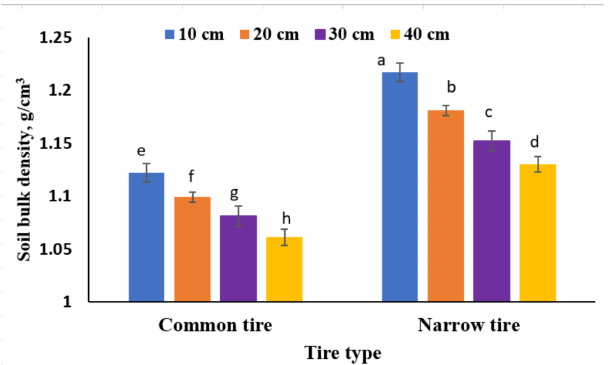
Figure 6. The main effect of tire type and depth on soil bulk density (different English alphabets shows significant difference between